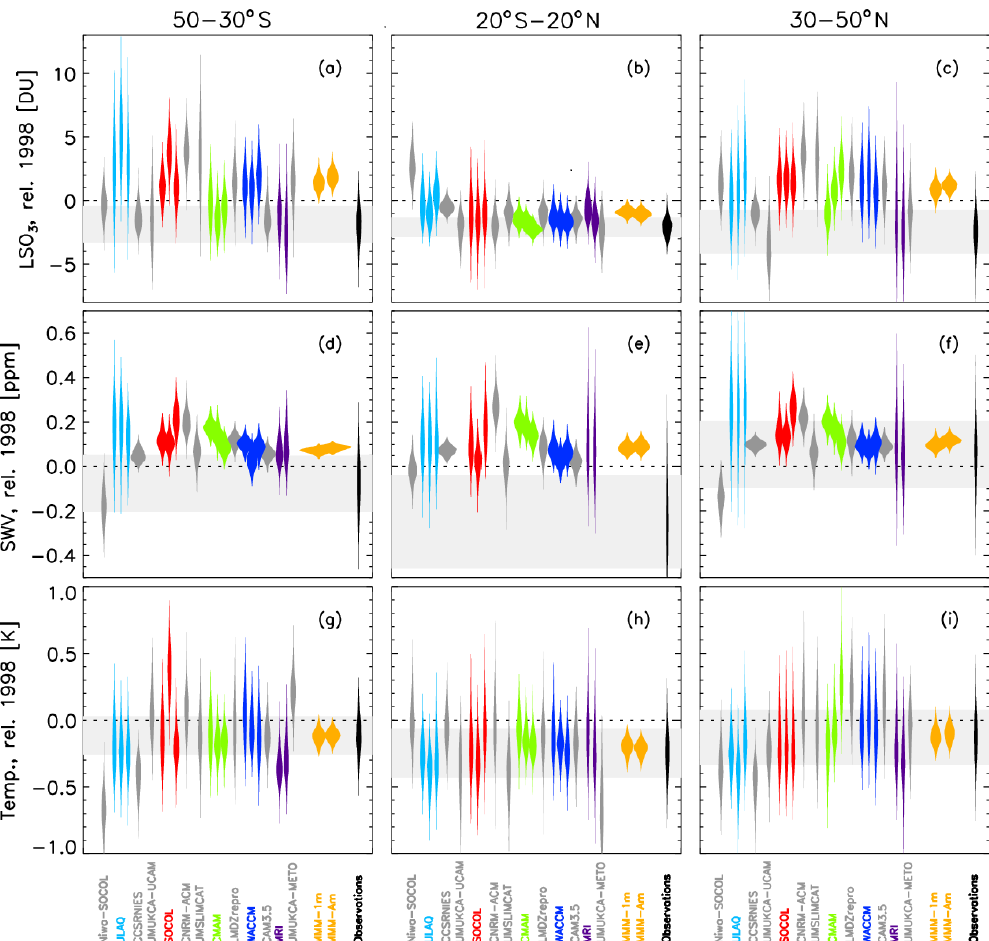
Figure 2. Lower stratospheric 1998–2016 ozone, water vapour, and temperature changes in models and observations. (a, d, g) 50–30 ◦ S, (b, e, h) 20 ◦ S–20 ◦ N, and (c, f, i) 30–50 ◦ N; (a–c) partial column ozone (147–32hPa, 50–30 ◦ S, 30–50 ◦ N; 100–32hPa, 20 ◦ N–20 ◦ S), (d– f) stratospheric water vapour (SWV) at 83hPa; (g–i) temperature estimated from the MSU4 observing kernel. Violins represent double-sided probability distribution functions. Observations are black (right), with grey bands representing the 68% highest density (most likely) interval; models are grey (single member ensembles), and colours are for models with more than one